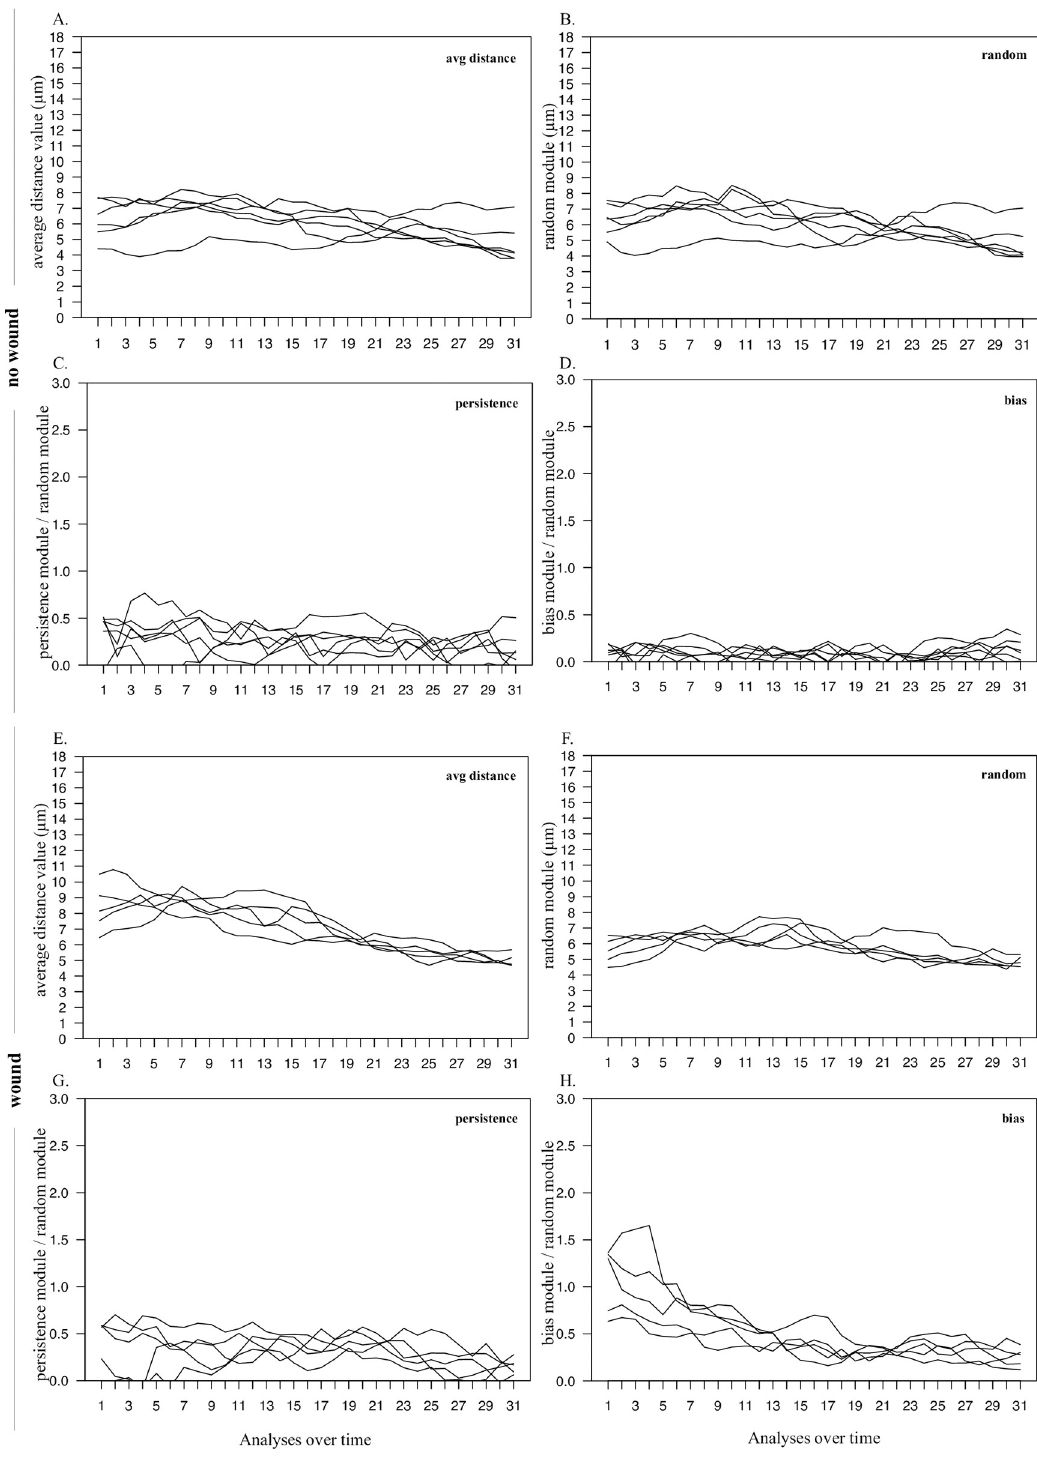
Fig 5. Movement components of HeLa populations over time. HeLa cell movement on a culture plate was evaluated both in absence (A-D) and in presence (E-H) of a wound stimulus. The line plots correspond to independent cell populations; for each of them, the plots report average displacements modules measured over 40 minute steps (A and E), as well as random (B and F) persistence (C and G), and bias (D and H) values, calculated from the observed displacements. Persistence and bias modules were normalized to the corresponding random module. All the values were evaluated at 40 minute intervals using the data from overlapping four hour windows. https://doi.org/10.1371/journal.pone.0272259.g005 PLOS ONE | https://doi.org/10.1371/journal.pone.0272259 August 2,